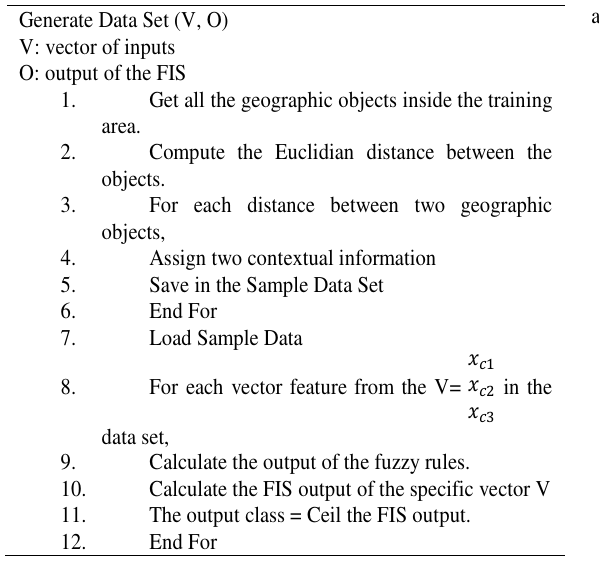
Figure 7. Fuzzy rules used to prepare the data set